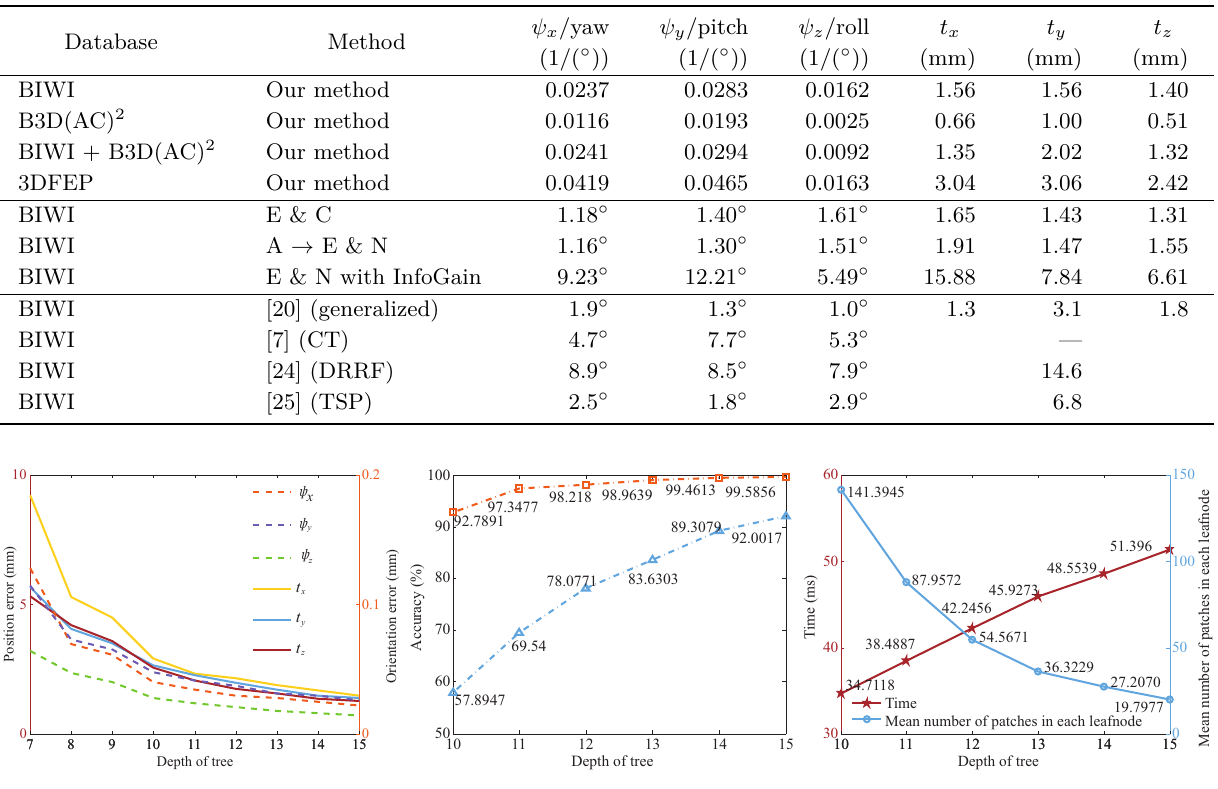
Fig. 7 Left: relationship between average error of each head pose component and depth of tree. The left-hand vertical axis measures the positional error of the nose (shown as solid lines) while the right-hand vertical axis represents the orientation error (dotted lines). Center: relationship between accuracy and depth of tree. Orange: ratio of samples whose position error satisfies [ t x < 5 ,t y < 4 ,t z < 4]. Blue: ratio of samples whose position error satisfies [ t x < 10 ,t y < 10 ,t z < 10]. Right: Relationship between depth of tree and